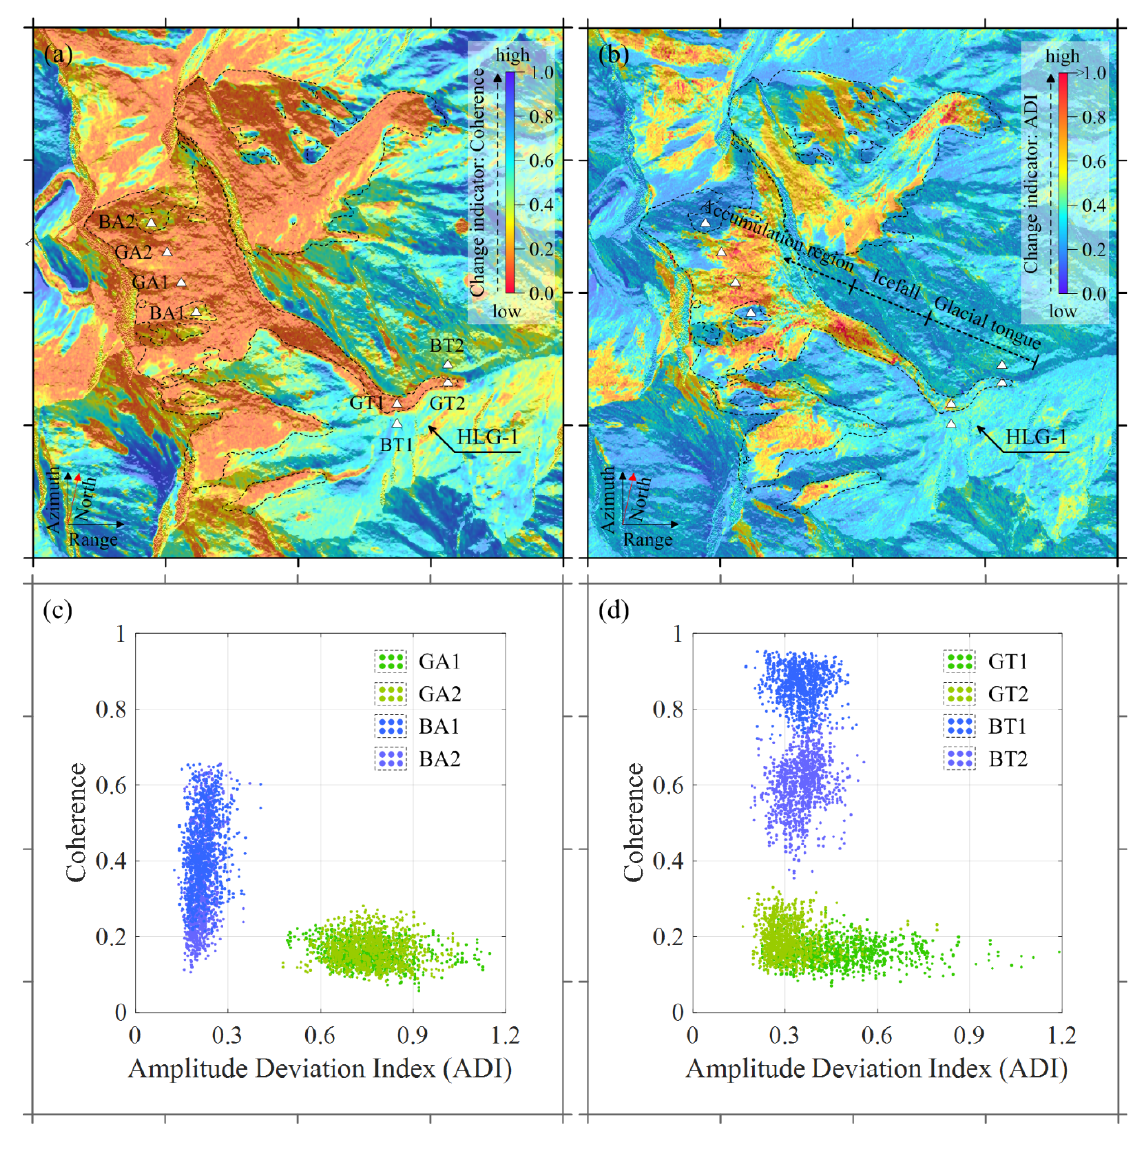
Figure 4. The average coherence map ( a ) and the ADI map ( b ). The black dashed line roughly marks the three sections of the HLG (the accumulation, icefall, and glacial tongue regions). The two-dimensional distribution of coherence and ADI for the four patches in and around the accumulation region; ( c ) similar to ( d ) but for the glacier tongue region. The locations of eight example patches selected according to GGI database are shown as triangles superimposed in ( a , b